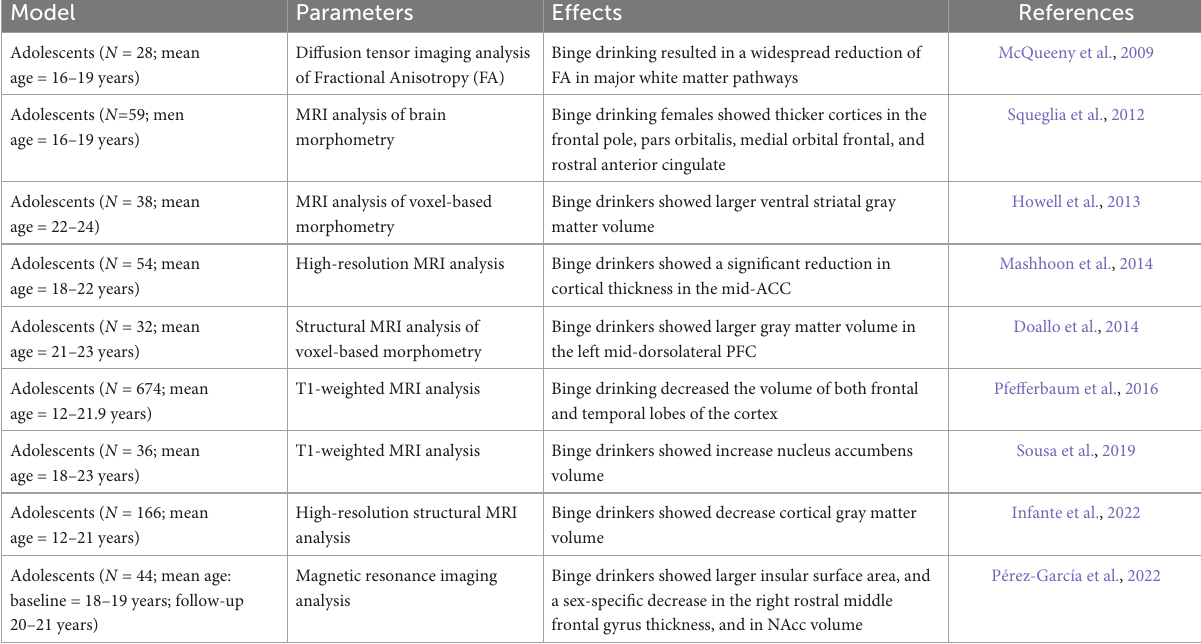
TABLE 1 Summary of studies exploring structural and functional anomalies in adolescent binge drinkers.